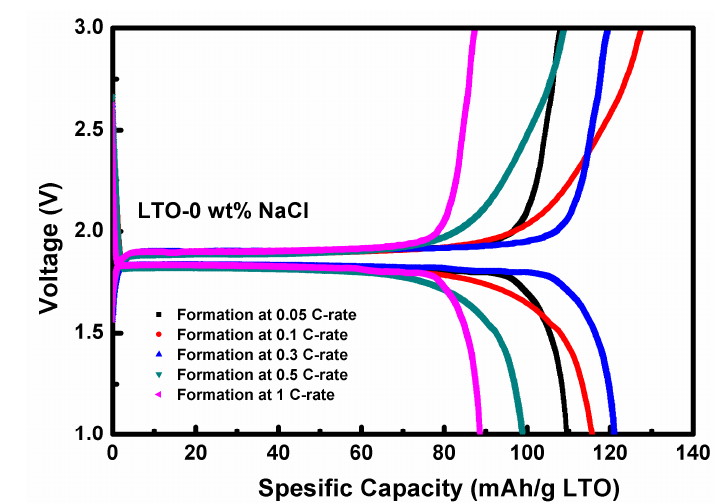
Figure A1. Synthesis process of Li 4 Ti 5 O 12 powder.